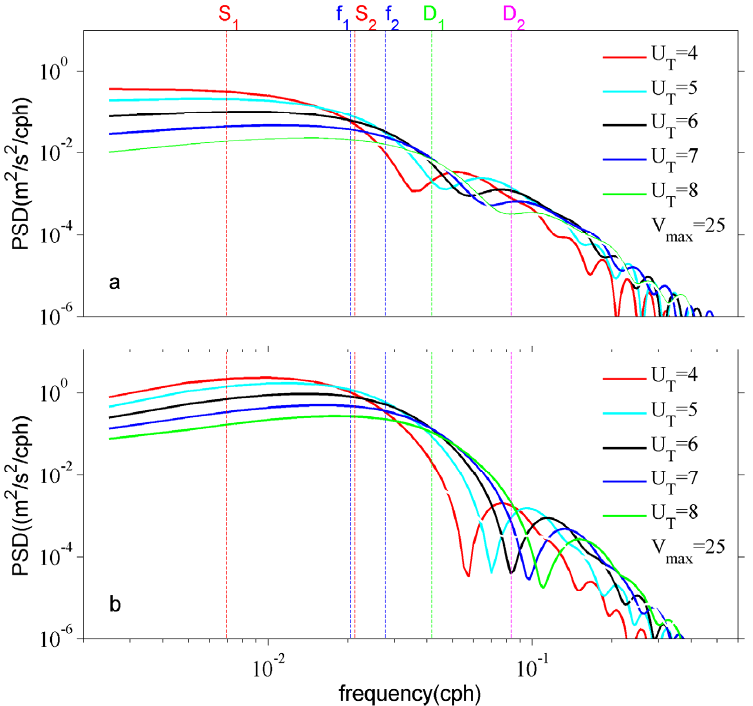
Figure 12. Power spectral densities (PSDs) of ( a ) eastward components and ( b ) northward components of wind stress at location B (solid lines). The blue dashed lines indicate the range of filtered near-inertial frequency band (f 1 –f 2 ). The red dashed lines indicate the range of synoptic frequency band (S 1 –S 2 ). The green and magenta dashed lines denote the diurnal (D 1 ) and semidiurnal (D 2 ) frequencies,